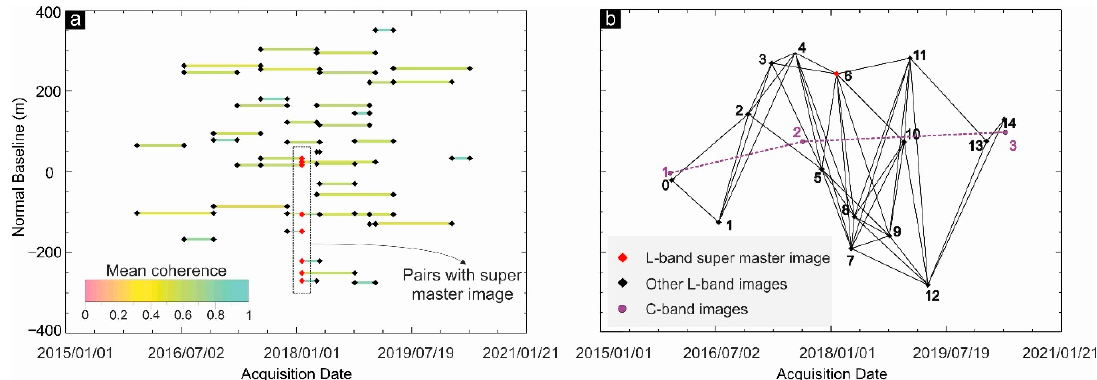
Figure 4. ( a ) Arrangement of interferometric synthetic aperture radar (InSAR) pairs and corresponding mean coherence values for each pair. ( b ) InSAR links of PALSAR-2 (black diamonds) and Sentinel-1 (purple circles). Super master image for small baseline subset (SBAS) analysis of PALSAR-2 data indicated by red diamond.